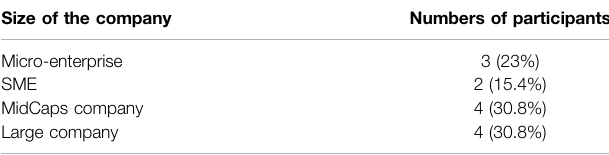
TABLE 5 | Number of participants with comments per company size.